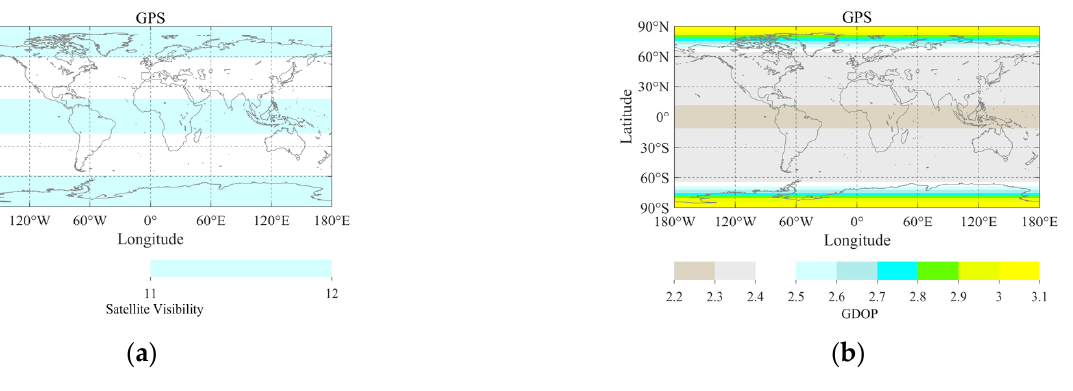
Figure 5. ( a ) visible satellites of GPS; ( b ) GDOP of GPS.